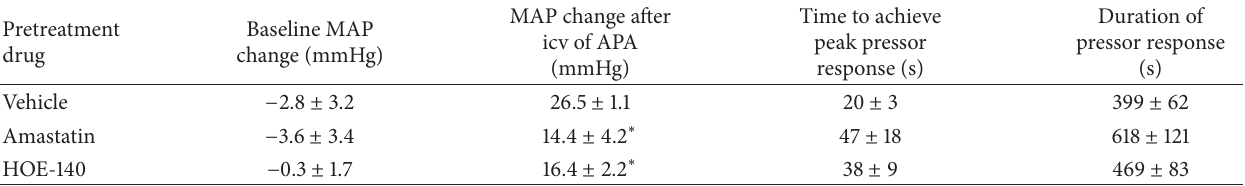
Table 3: Intracerebroventricular (icv) administration of 800 ng of aminopeptidase A (APA) after icv administration of vehicle, amastatin, or HOE-140.